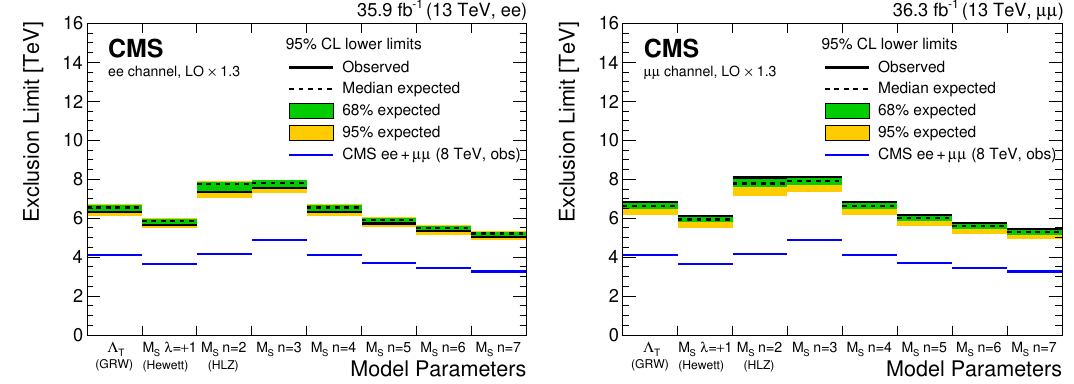
Figure 4 . Exclusion limits at 95% CL on the UV cuto(cid:11) for the electron (left) and muon (right) channels with m ‘‘ > 1 : 8 TeV in the GRW, Hewett, and HLZ conventions for the ADD model. Signal model cross sections are calculated up to leading order and a correction factor of 1.3 is applied. The results are compared to the previous combined result from CMS [8].